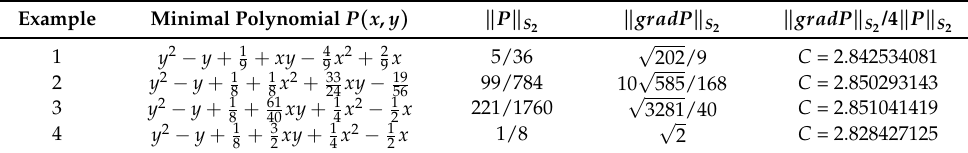
Table 2. Constants C in Markov inequalities on the simplex for exemplary